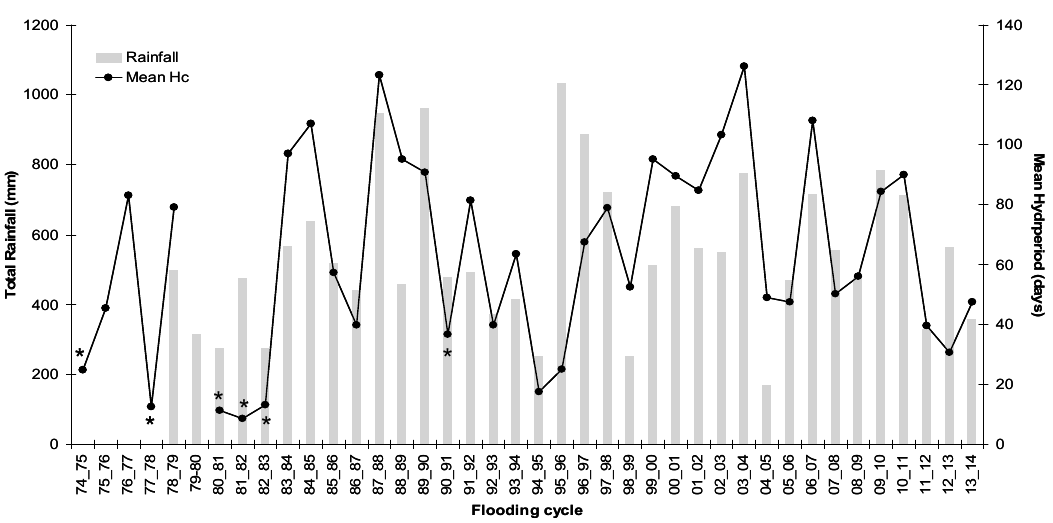
Figure 6. Mean marsh hydroperiod versus total accumulated rainfall per flooding cycle. Asterisks indicate the discarded cycles for time series analysis. Rainfall data available since 1978.